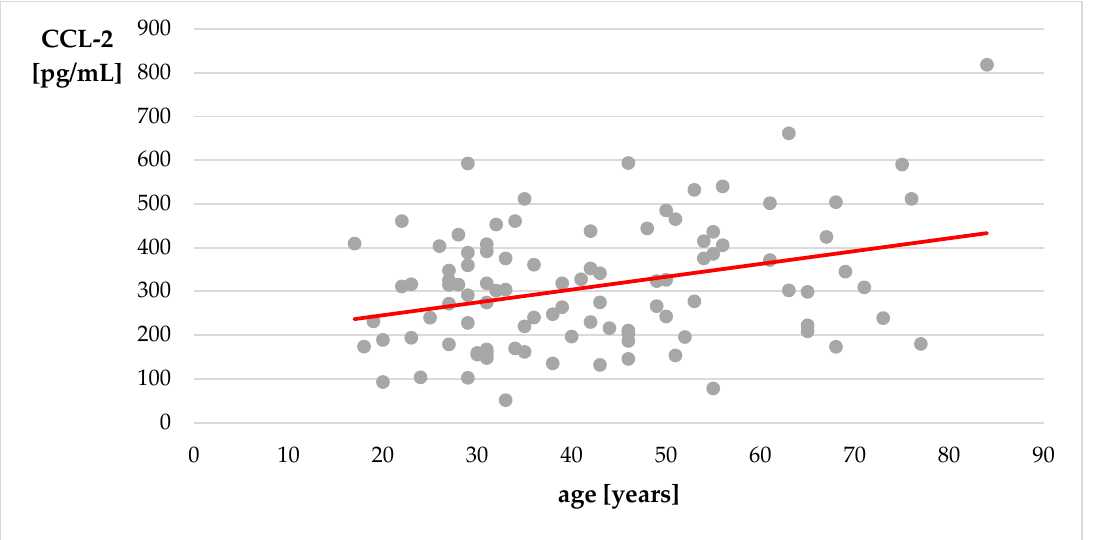
Bold font indicates statistical significance.